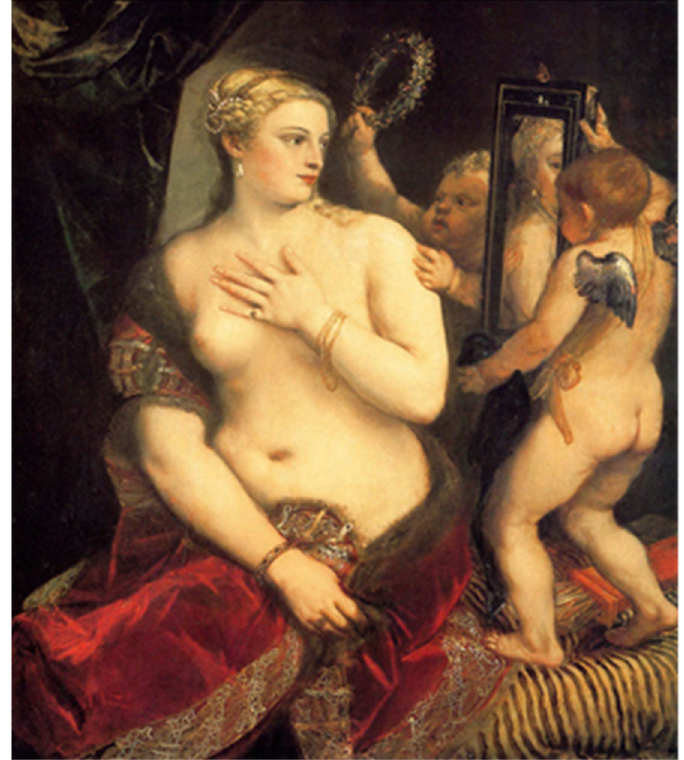
Figure 2. Titian. “Venus with a Mirror” (circa 1555). Peter Paul Rubens (Figure 3: “Venus at a Mirror,” 1615; http://rybens.ru/woman/rubens2 .php (accessed on 25 September 2022)): she is portrayed from behind in profile, and in the mirror her face is in